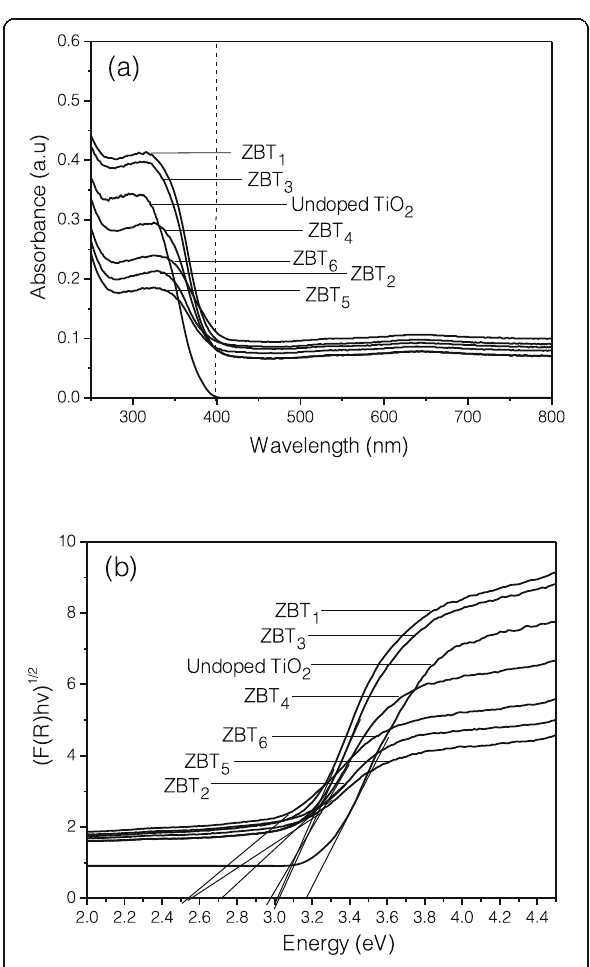
Fig. 4 ( a ) The DRS spectra of undoped TiO 2 and co-doped TiO 2 with different wt% of Zn & B ( b ) Kubelka-Munk function (F(R)hv) 1/2 vs photon energy (hv) for determining bandgap energy